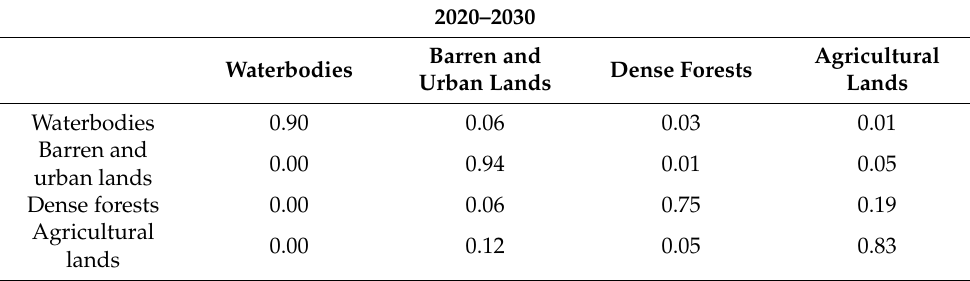
Table 7. Land use transition matrix of the year 2030, 2040, and